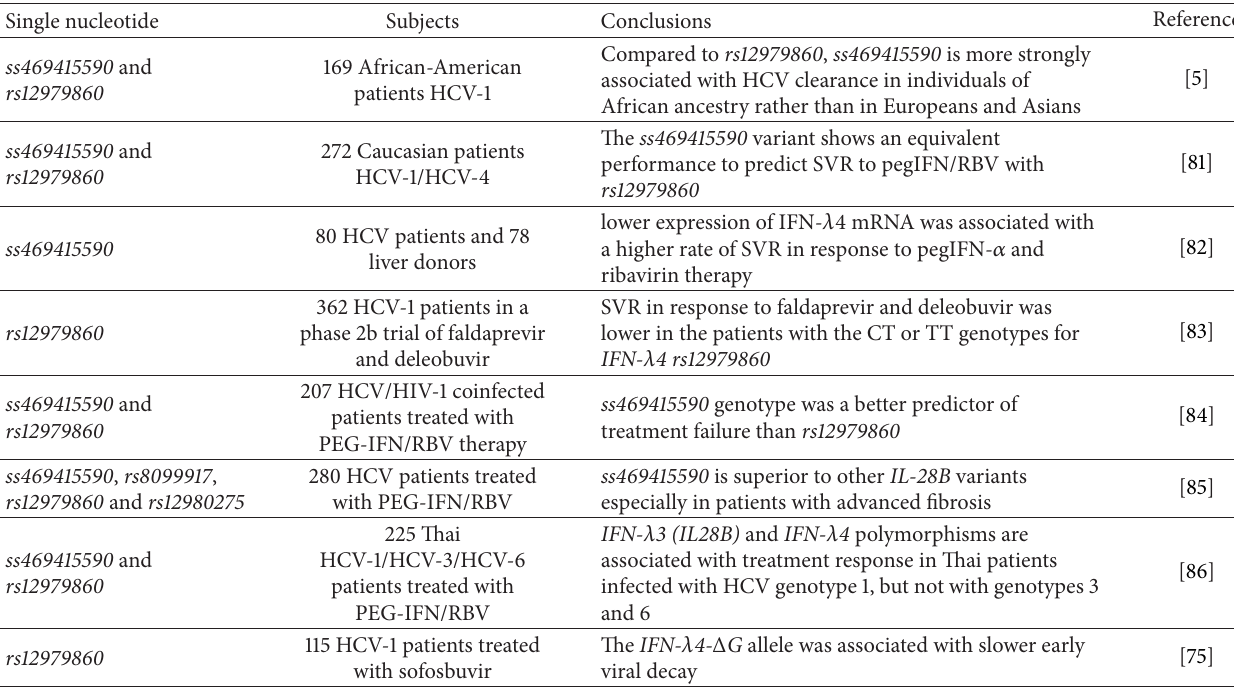
Table 1: Genetic association studies of IFN- 𝜆 4 and treatment